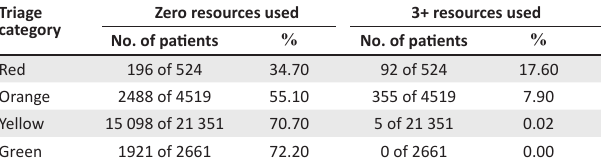
TABLE 4: Number of patients using zero resources per triage category and number of patients using three or more resources per triage category in a private emergency centre in Pretoria in 2018.